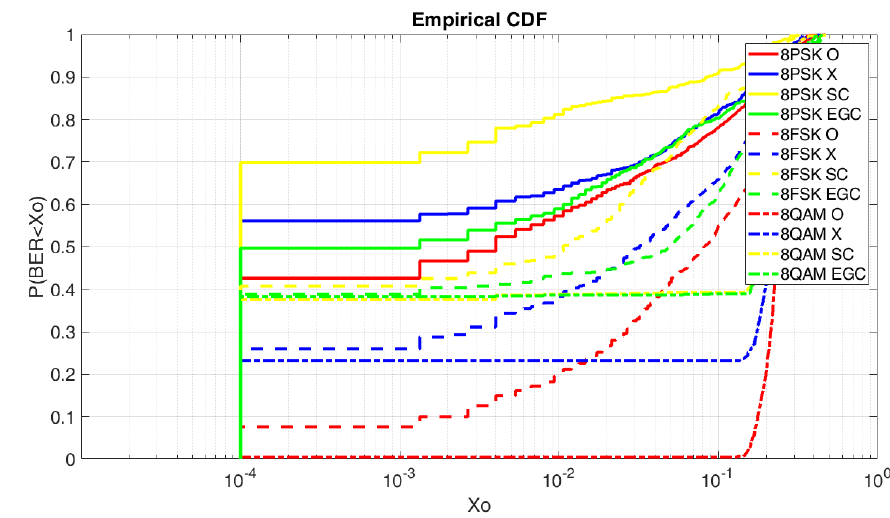
Figure 9. BER CDF order 8 modulations at 50 W.